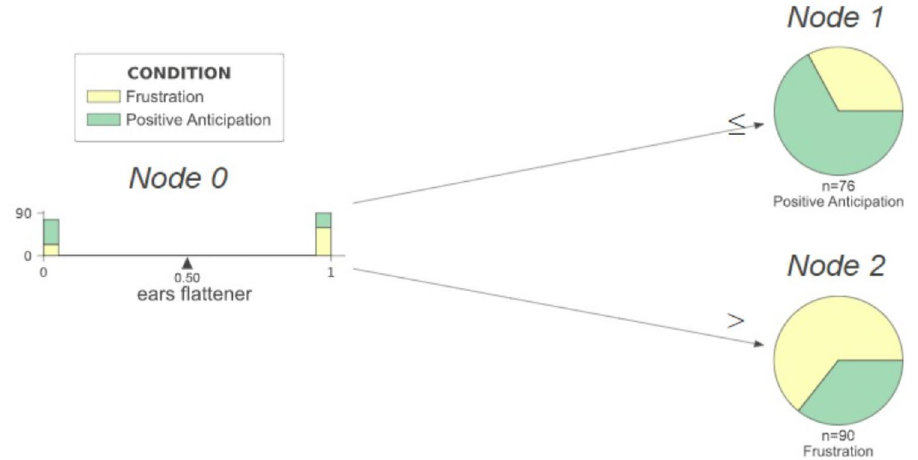
Figure. 4. Reduced decision tree (with 11 DogFACS variables).